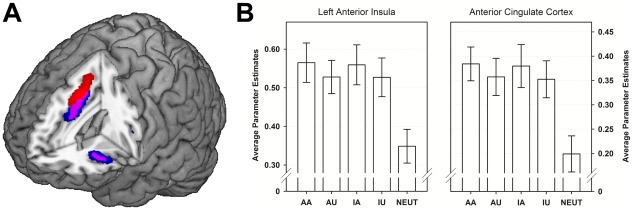
Neural activation and average parameter estimates during vicarious embarrassment.
A Activations in response to vicarious embarrassing situations within the anterior cingulate cortex (ACC) and left anterior insula. The rendered image displays the results of a random-effects analysis contrasting vicarious embarrassing with neutral situations. Positive effects of a conjunction analysis (AA > N ∩ AU > N ∩ IA > N ∩ IU > N) thresholded at p<.05, FWE-corrected (red and pink areas) are superimposed on the regions-of-interests which were generated in the ACC and the anterior insula at a more liberal threshold, p<.001, uncorrected (blue and pink areas). B Average parameter estimates within the ACC and the left anterior insula masks during the processing of vicarious embarrassing (AA, AU, IA, IU) and neutral situations (NEUT).